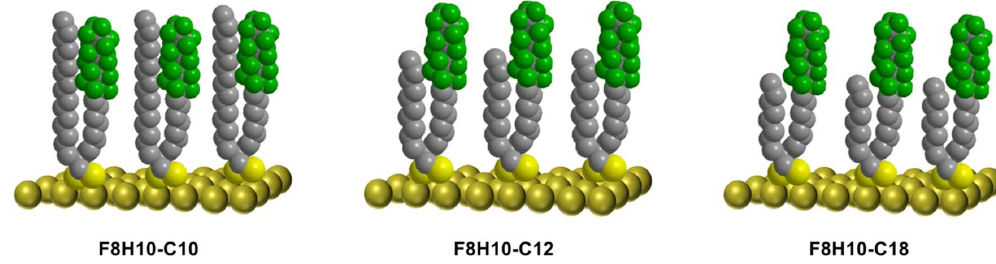
Figure 2. Illustration of idealized SAMs on gold derived from F8H10-C10 , F8H10-C12 , and F8H10-C18 .